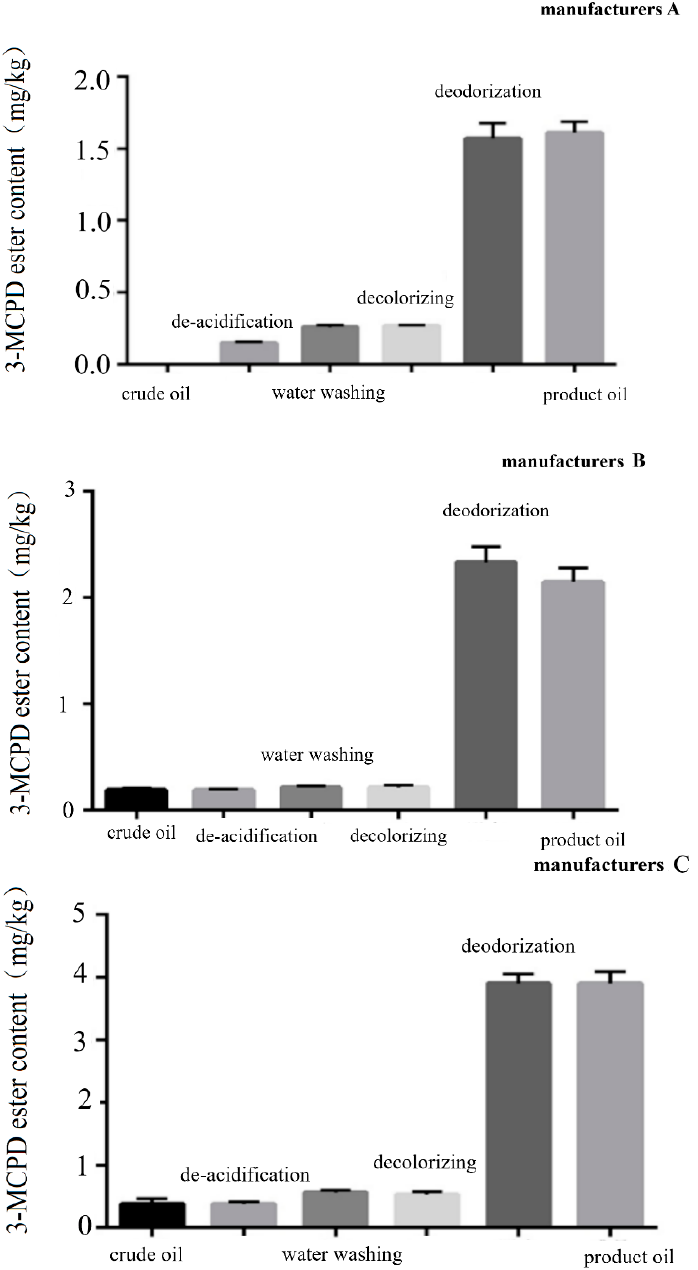
Figure 2. The influence of different refining processes on the formation of 3-MCPD ester, measured in the camellia oil refining process of three different manufacturers ( A – C ).